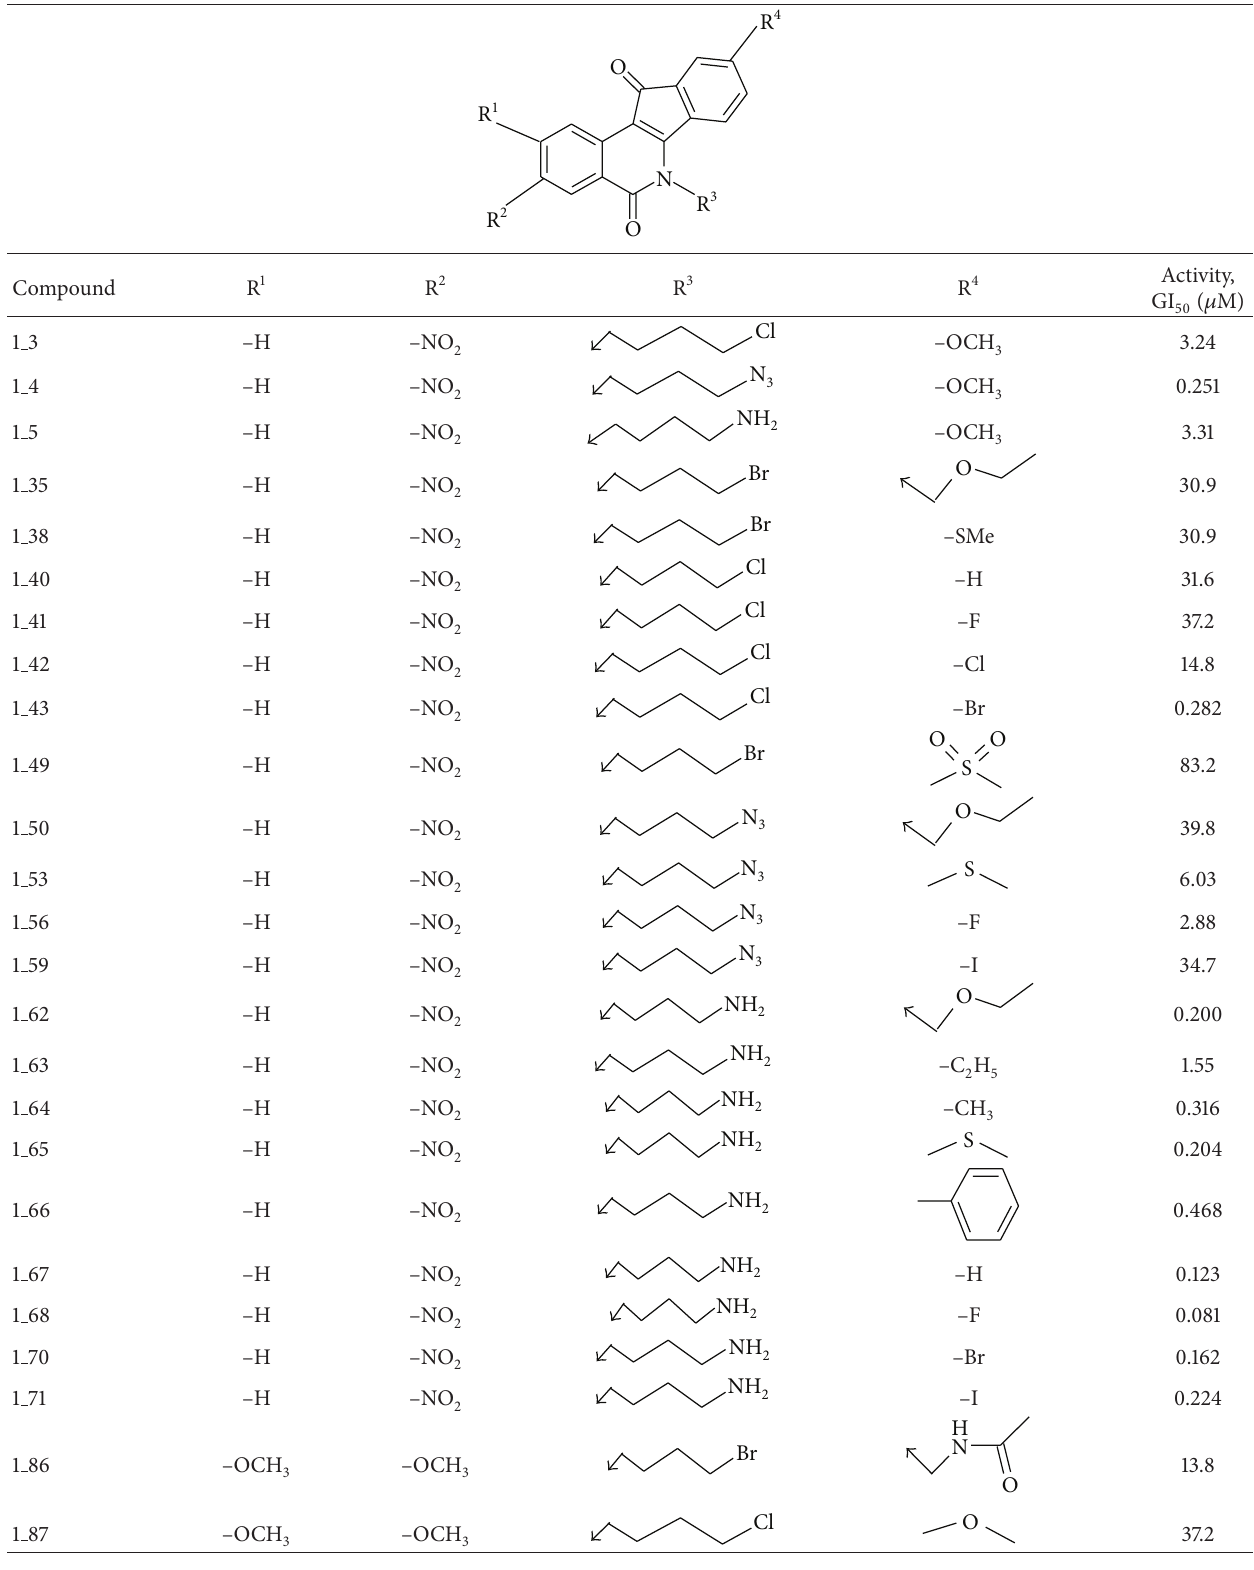
Table 1: Structures of the indenoisoquinoline derivatives as topoisomerase I